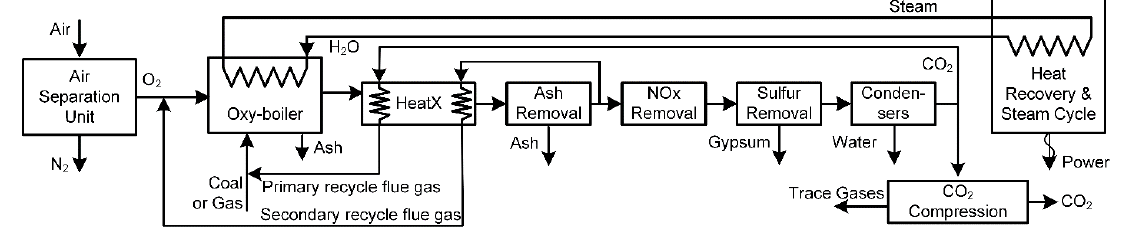
Figure 5. An example oxyfuel process, based on [41].